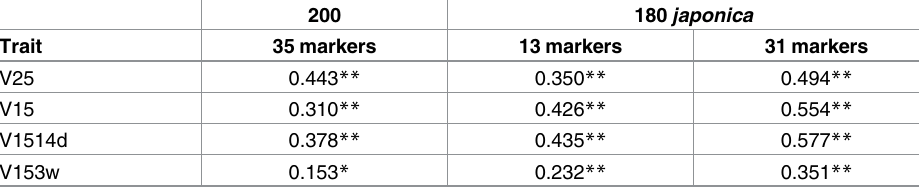
Table 5. Spearman correlation coefficients estimated between the phenotypes and the numbers of favourable alleles in three panels of markers(35, 13 and 31 SNPs) associated to four traits in the two sets of 200 and 180 rice